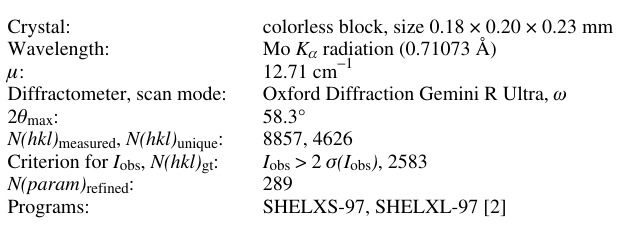
Table 1. Data collection and handling.